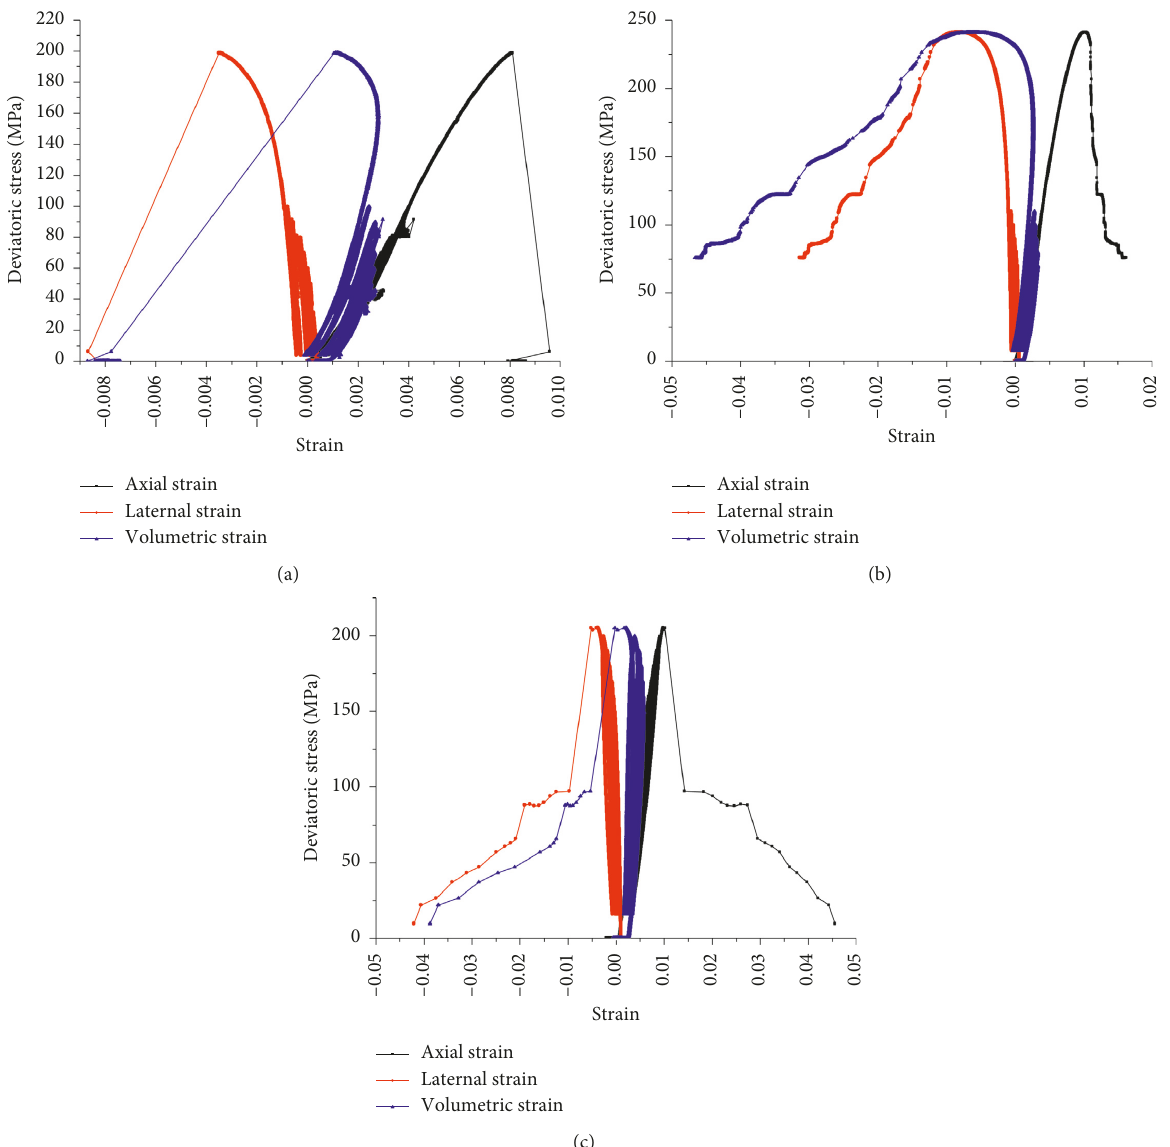
Figure 7: The stress-strain curves of b2 rocks under cyclic loading-unloading conditions: (a) b2-4-1; (b) b2-4-2; (c)